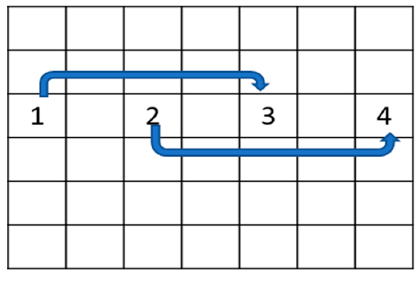
Figure 5. Potential Field Method Wayfinding.